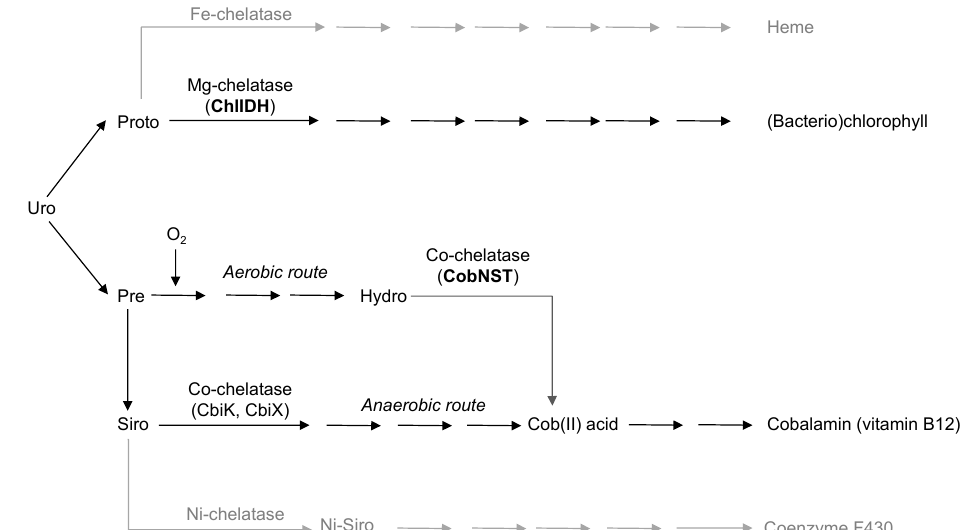
Figure 1. Overview of the existing biochemical pathways that produce (Bacterio)chlorophyll, Heme, Cobalamin, and Coenzyme F430 from Uroporphyrinogen III (Uro). The magnesium-chelatase ChlIDH inserts Mg 2 + ion in the Protoporphyrin IX (Proto). There are two alternative pathways to synthesize Cobalamin. The CobNST chelatase inserts Co 2 + in the aerobic path. It has been suggested that ChlIDH and CobNST have common evolutionary